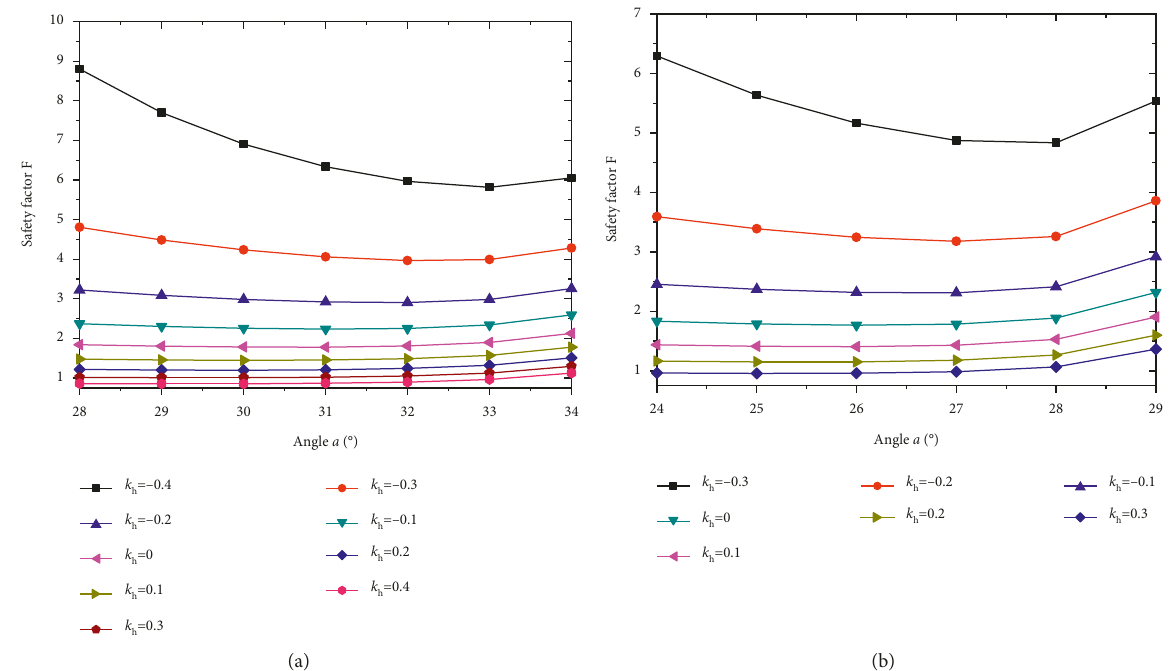
Figure 10: Effect of horizontal seismic acceleration coefficient on safety factor F and inclination angle α . (a) Result of case 1 ( h � 2m). (b) Result of case 2 ( h � 3 m).